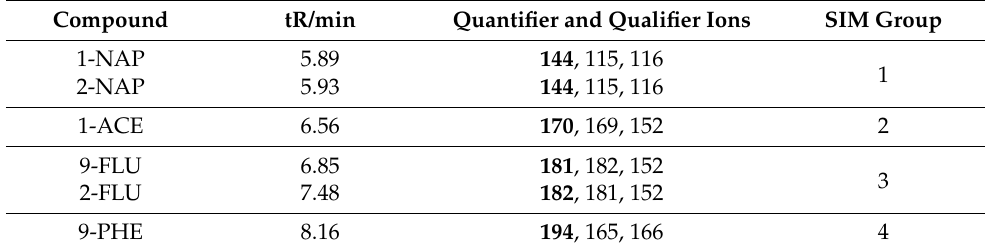
Table 2. Retention times, selected ions for quantification (in bold) and identification of OH-PAHs including internal standard, and SIM groups